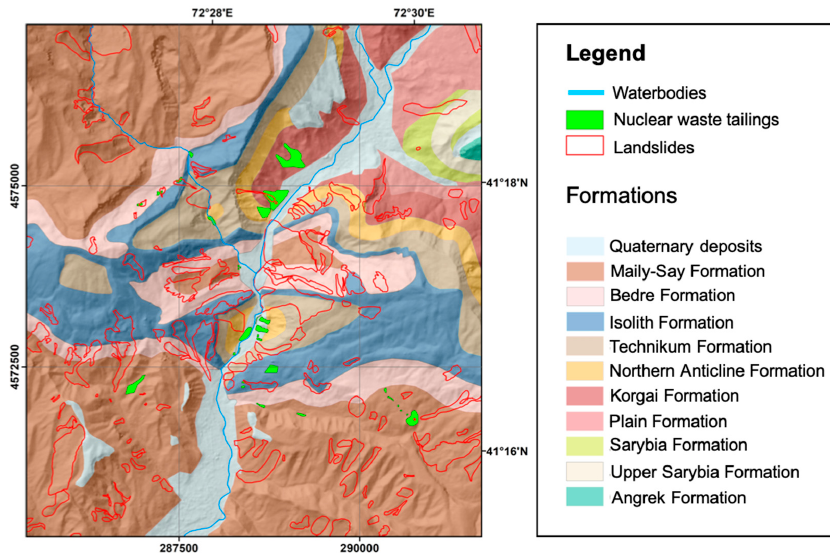
Figure A1. Geological map projected on the TanDEM-X 12 m hillshade of the Mailuu-Suu target area, with the location of nuclear waste tailings (green) and landslides (red outlines), as mapped by Schlögel et al. [23].